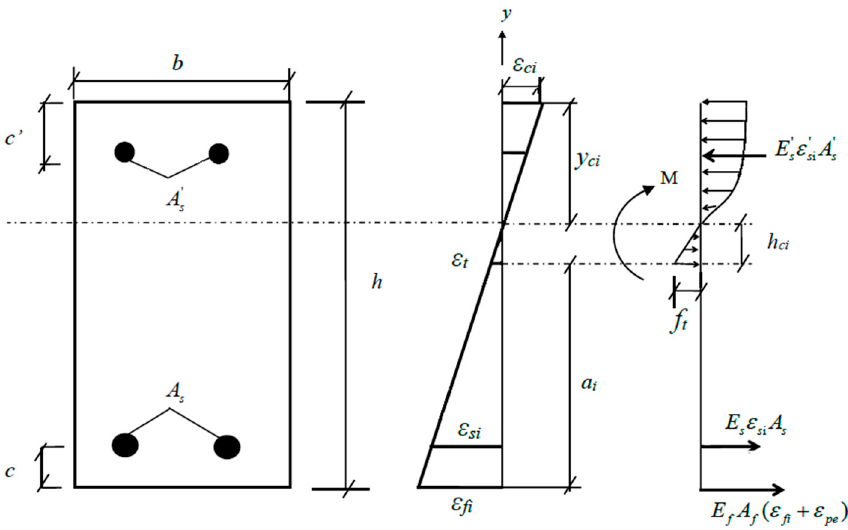
Figure 2. Stress-strain distribution at the main cracked section.